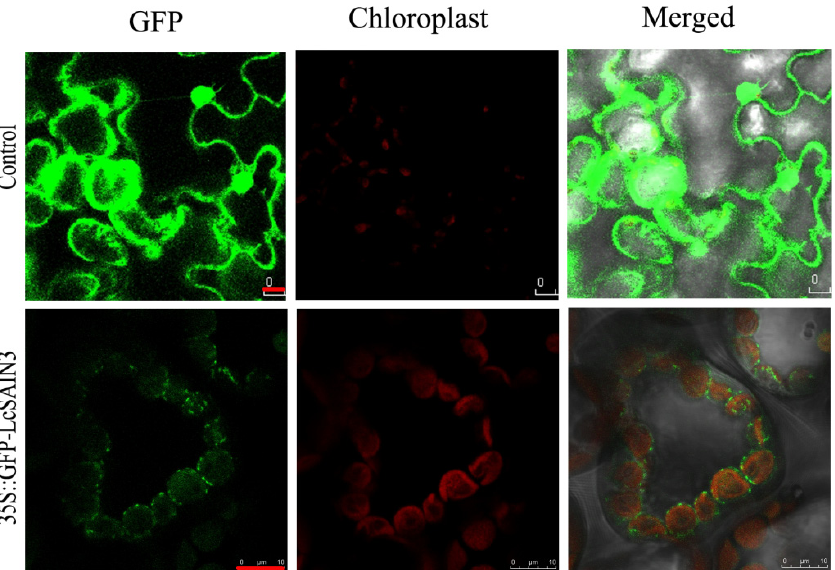
Figure 3. The subcellular localization of LcSAIN3. The GFP signals arising from the GFP control (upper) and 35S::GFP-LcSAIN3 fusion protein (bottom lane) expressed in tobacco leave cells were detected under fluorescent-field illumination, chloroplast autofluorescence, and an overlay using a confocal microscope. Red signals represent chloroplast autofluorescence. Scale bar = 10 μ m.